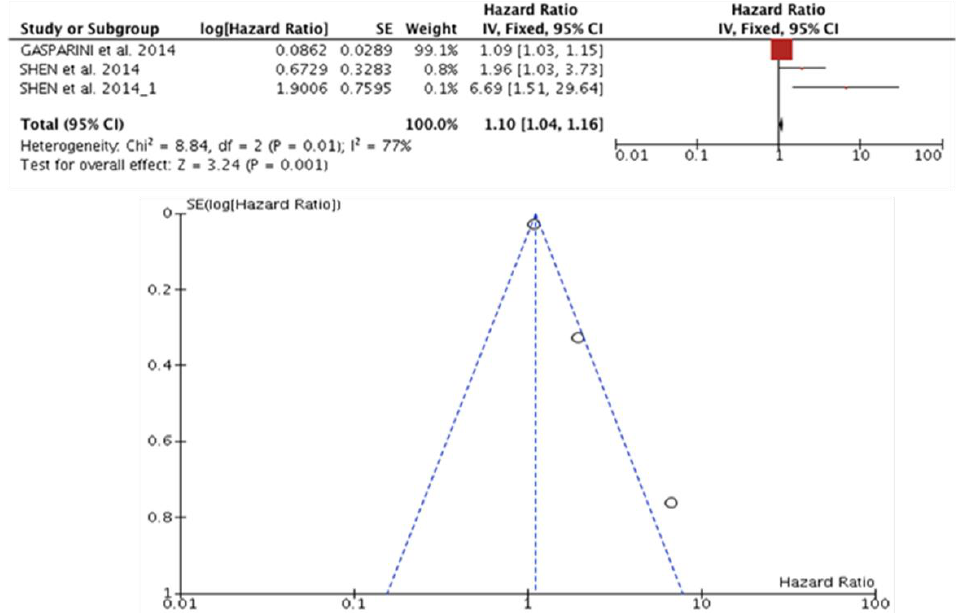
Figure 7. miR-27 and prognosis in TNBC. High miR-27a/b expression in TNBC patient is associated with worse prognosis in OS (HR: 1.10; 95% CI: 1.04–1.16; I 2 = 77%, p = 0.01), Z = 3.24 ( p < 0.001)